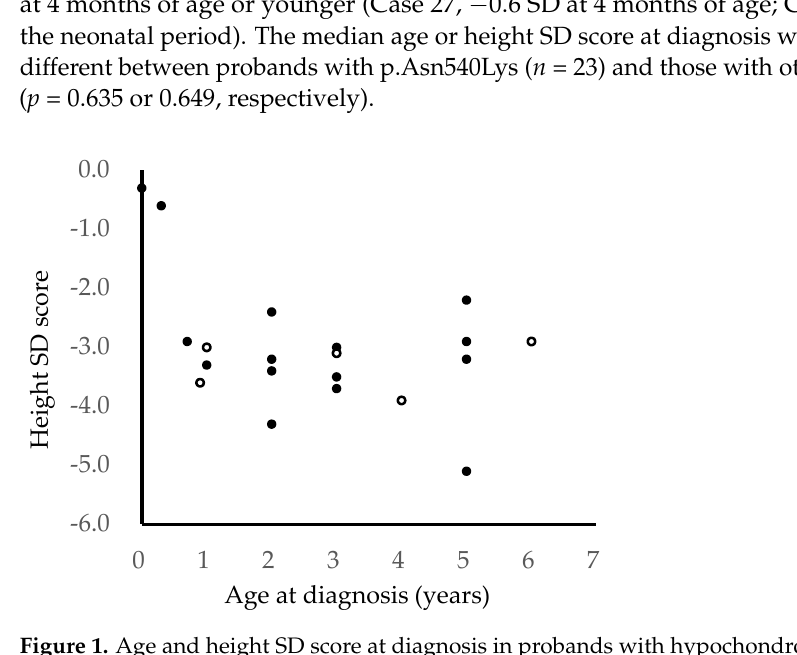
Figure 1. Age and height SD score at diagnosis in probands with hypochondroplasia. Filled circles indicate those with p.Asn540Lys, and open circles show those with other variants.